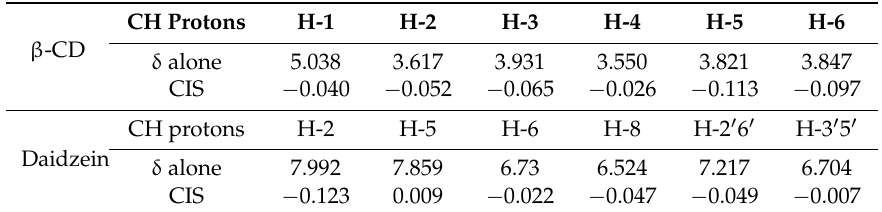
Table 1. 1 H-NMR Chemical shifts ( δ , ppm) for CH protons of β -CD alone, daidzein alone and their complexation induced shifts (CIS = δ complex ´ δ guest ) in D 2 O at 30 ˝ C.